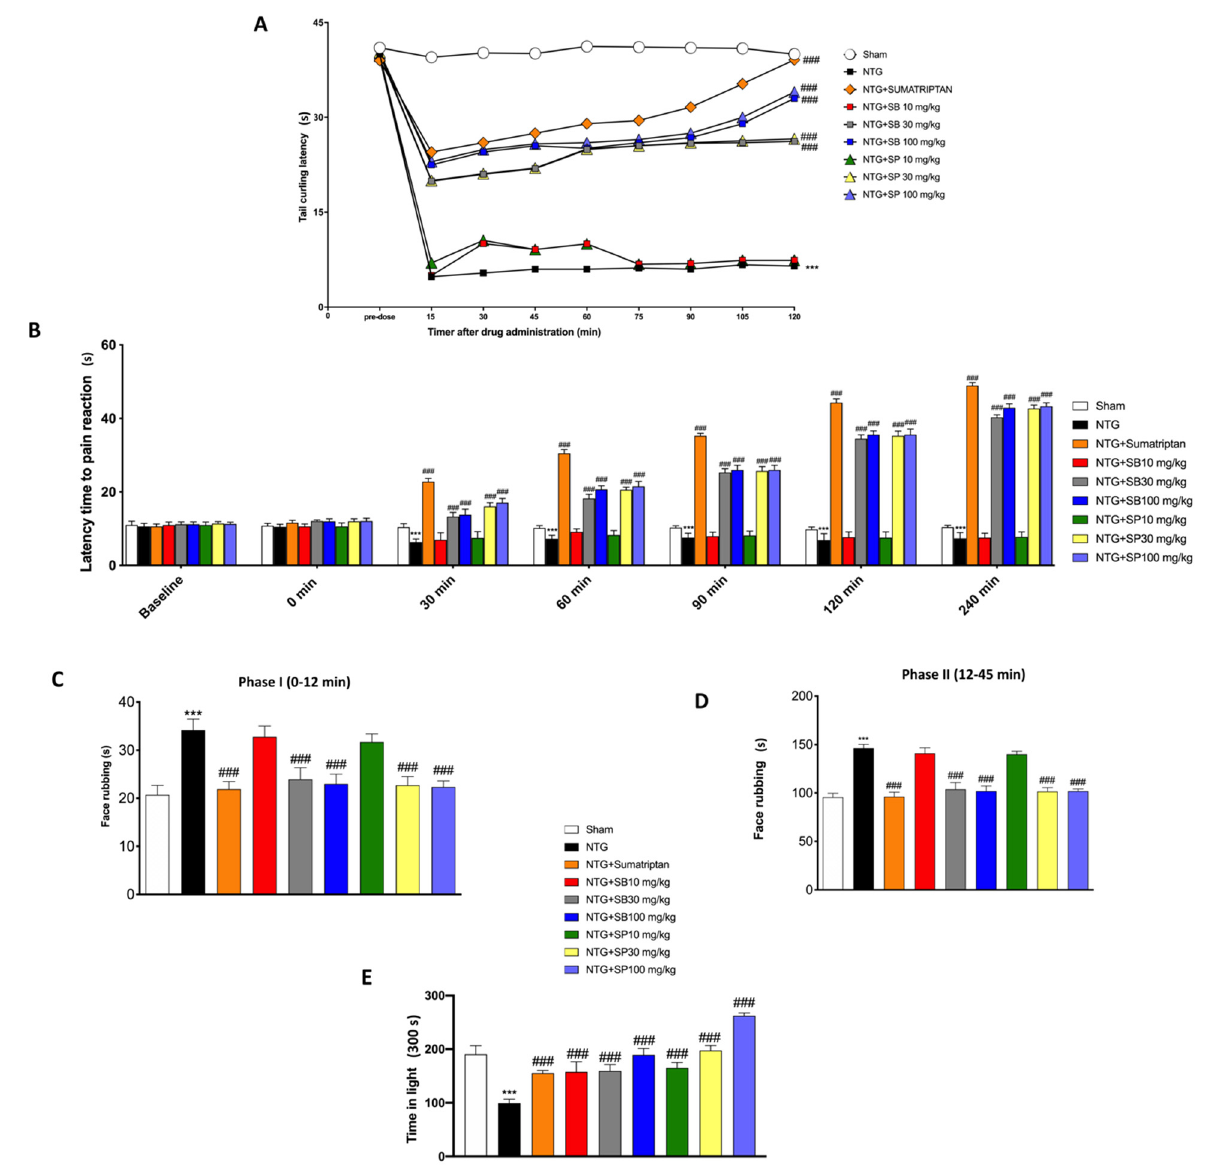
Figure 1. SCFA treatments reduces NTG-induced hyperalgesia and pain. NTG injection considerably decreases tail flick latency compared to sham mice ( A ). SCFA treatment of 30 mg/kg and 100 mg/kg significantly increases tail flick latency ( A ) and significantly increases latency time for pain reaction already after 30 min following NTG injection ( B ). NTG administration considerably increases the total time of rubbing in Phases I and II of the orofacial formalin test compared to the sham group. The highest doses of SCFA treatments meaningfully reduces face rubbing time in both phases ( C , D ). Time in light exposure decreases in NTG-injected mice, compared to the sham group ( E ), while the treatment with SCFAs significantly reduces photophobia ( E ). Data are representative of at least three independent experiments. One-way and two-way ANOVA test. *** p < 0.001 vs. sham; ### p < 0.001 vs. NTG. N = 10 mice/group for each technique.